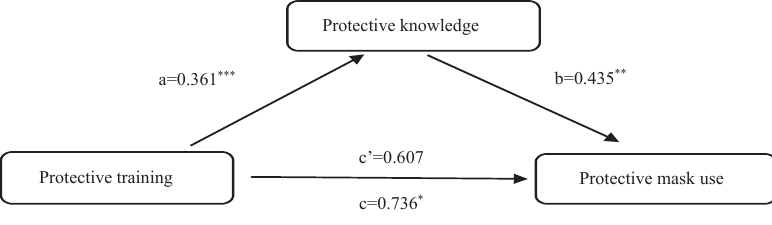
Figure 3. Mediation effect of protective knowledge on the association of protective training regarding AD exposure with protective mask use. Note : The proportion of mediation =27.2%.